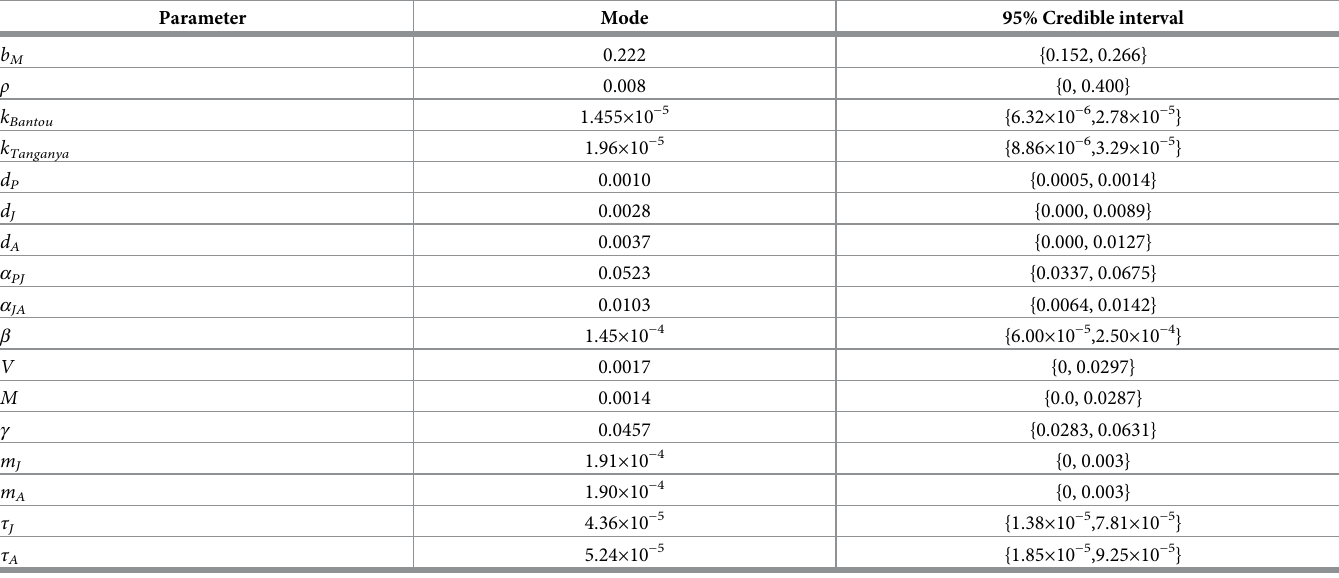
Table 3. Univariate modes and 95% credible intervals (highest posterior density) for model parameters.